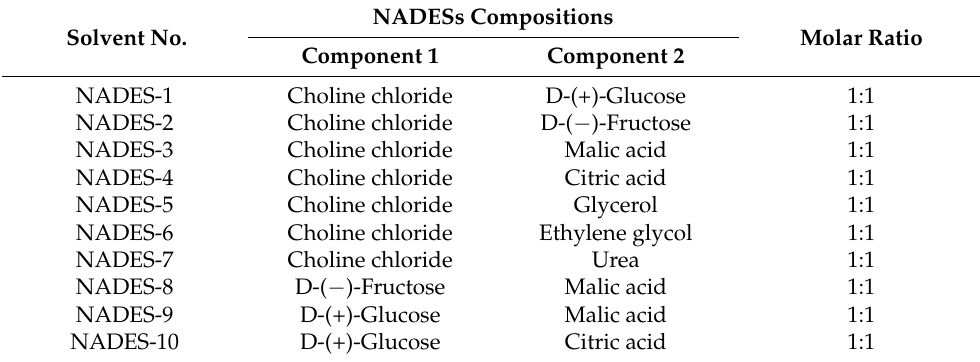
Table 1. Preparation of different